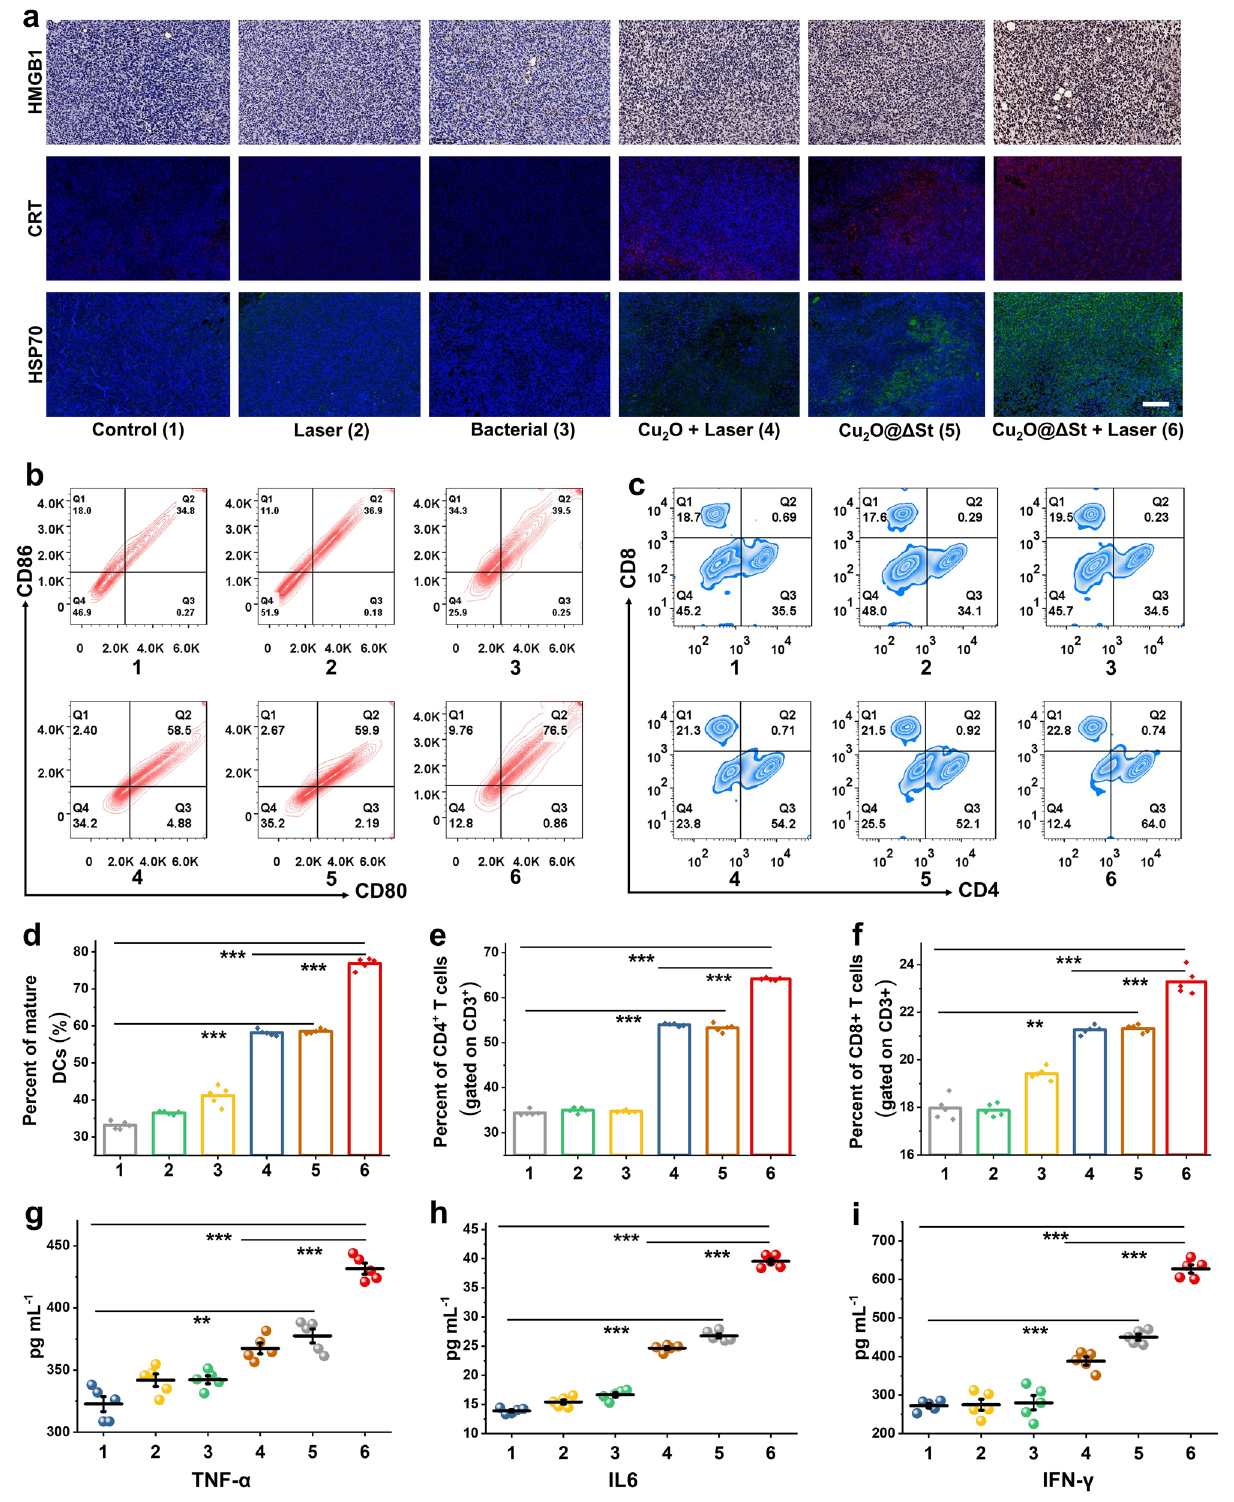
Fig. 6 Immune activation evaluation in vivo. a Immunofluorescence analysis of specific protein expressions after different treatments (HMGB1, CRT, and HSP70) from tumor tissue (scale bar, 100 μm). b Flow cytometry analysis and d quantification results of in vivo mature DCs in tumors of mice after different treatments (gated on CD11c + DC cells). c Flow cytometry analysis and e, f quantification results of CD4 + /CD8 + T cells (gated on CD3. + T cells) ( n = 5, mean ± standard error). The contents of g IL-6, h TNF-α, and i IFN-γ in tumor tissues of mice after different treatments measured by ELISA ( n = 5, mean ± standard